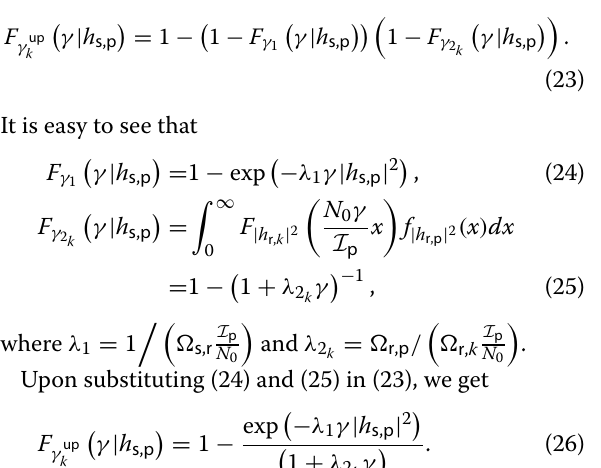
signals from a primary user [39], or by exchange of chan- nel information between primary and secondary users through a band manager